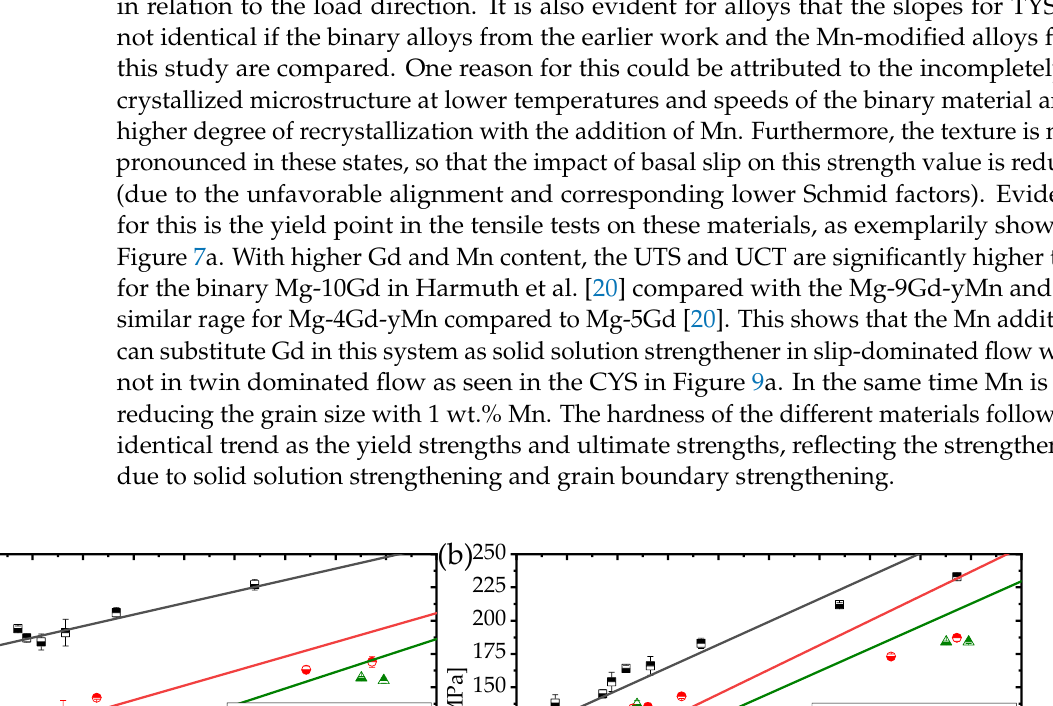
13 of 17 The strengthening can be referred to a solid solution strengthening by alloying addi-